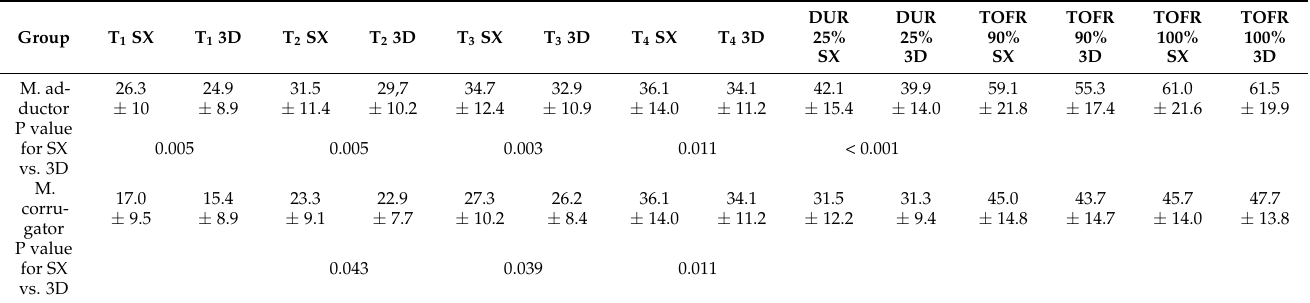
Table 2. Time course of the neuromuscular block: Reappearance of T 1 – T 4 , DUR 25%, TOFR 90%, TOFR 100%. Values are presented in min ± SD.